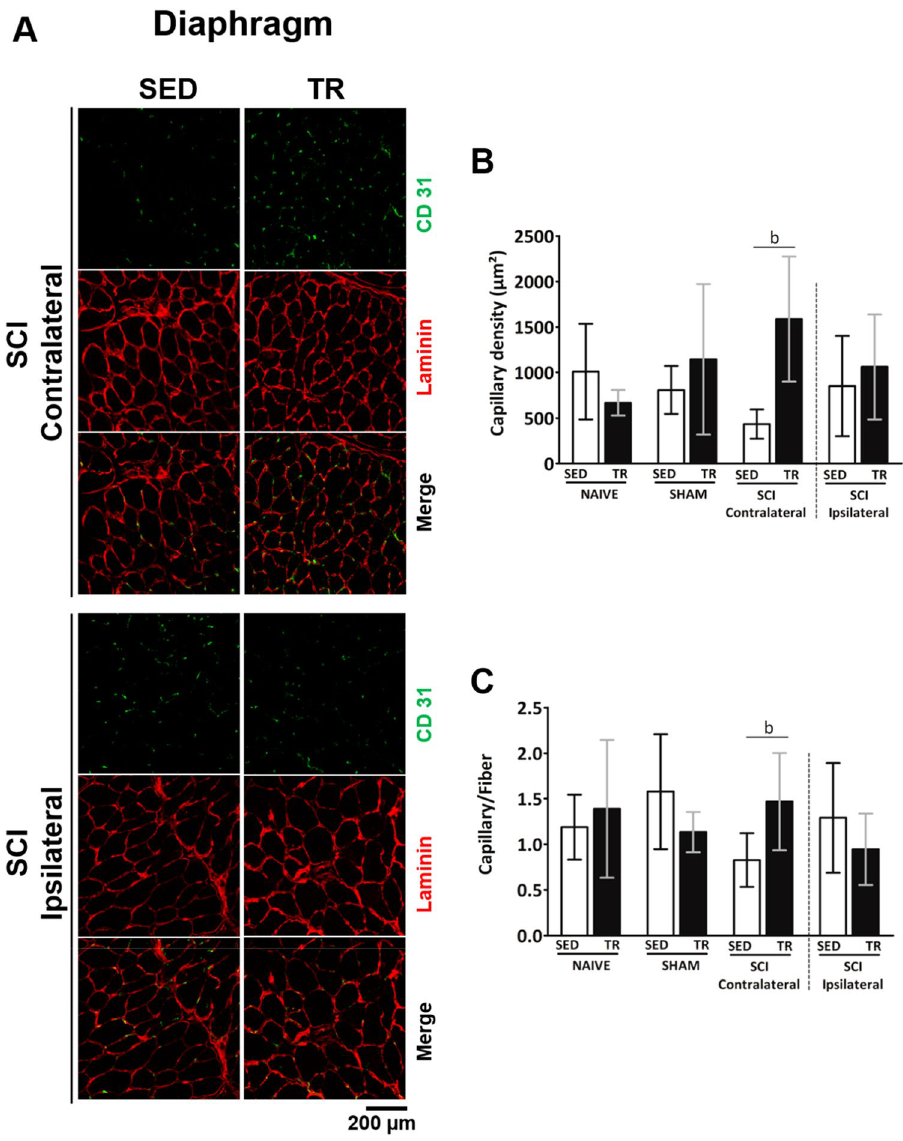
Figure 9. Analysis of endothelial cells on respiratory muscle. ( A ). Cryosections were immunostained to visualize CD31 (green) co-labeled with an anti-Laminin antibody (in red) in the diaphragm muscle. Scale bar = 200 μm. Comparison of CD31 expression and number of fibers in the diaphragm muscle represented by SED and TR SCI groups, while NAIVE and SHAM groups (SED and TR) are illustrated in supplemental Figs. 3. Scale bar = 200 μm. ( B ) Capillary density and ( C ) Ratio between capillary and fiber. Data are presented as mean ± SD (n = 6). Significance: b p < 0.05 compared to SED